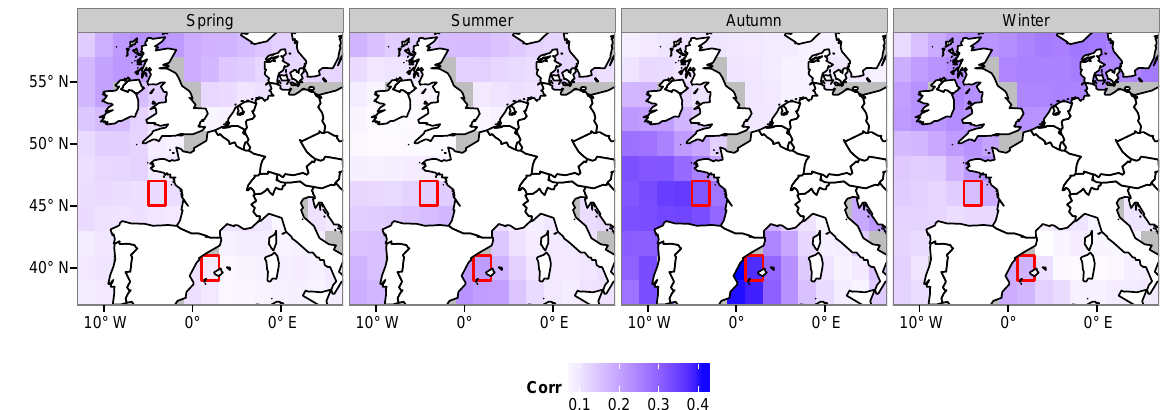
Figure B1. Median of the absolute values of the rank correlations between SST and precipitation from the 608 climatically homogeneous zones over the 1959–2007 period. Selected grid cells with high correlations are highlighted in red.